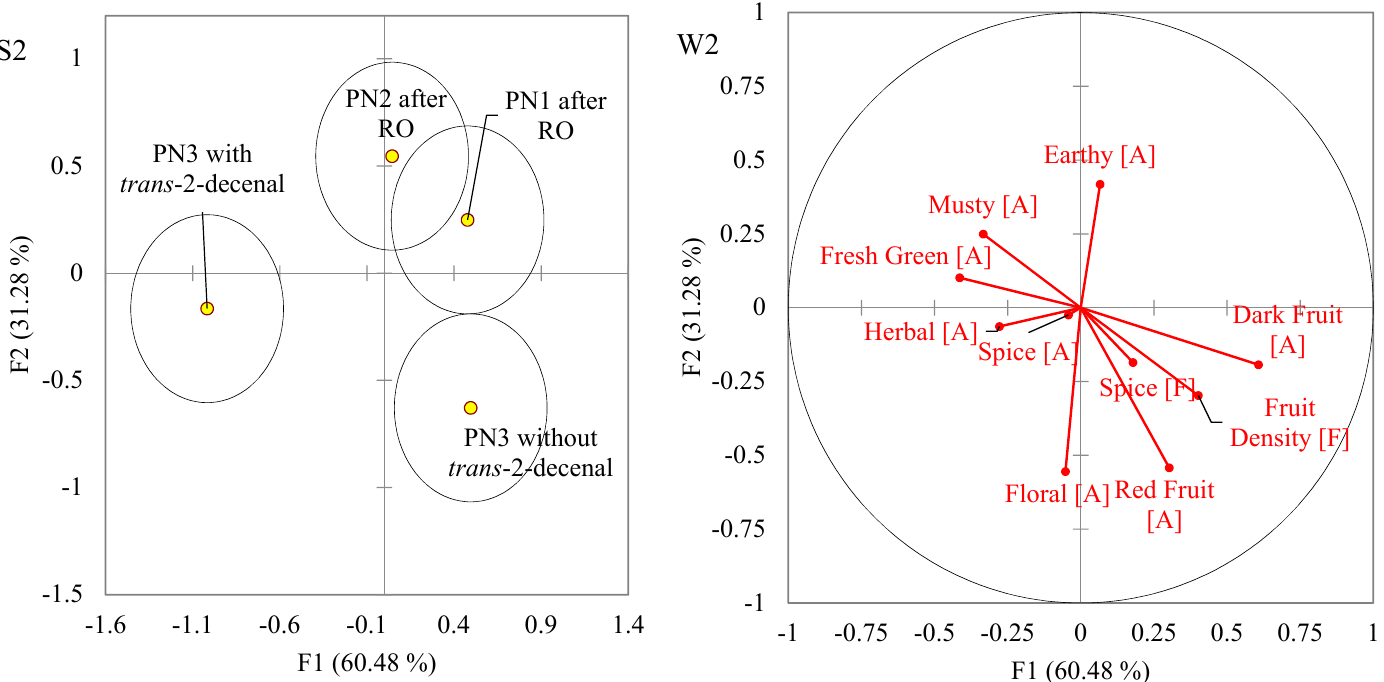
Figure 3. Separation among wines that went through reverse osmosis (RO) filtration: PN1 (wine made from BMSB free grapes), PN2 (wine made from BMSB containing grapes and contains 1.82 µ g/L of trans -2-decenal) and wines that did not go through reverse osmosis (RO) filtration: PN3 without added trans -2-decenal, PN3 with trans -2-decenal (23.88 µ g/L) by CVA. Wines are positioned using the centroids. Circles represent 95% confidence intervals surrounding the wine means. Vectors for sensory terms (A = aroma, F = in mouth flavor) are in W2 and scores for wines are in S2. Significant differences for wines are for circles that do not touch in S2.